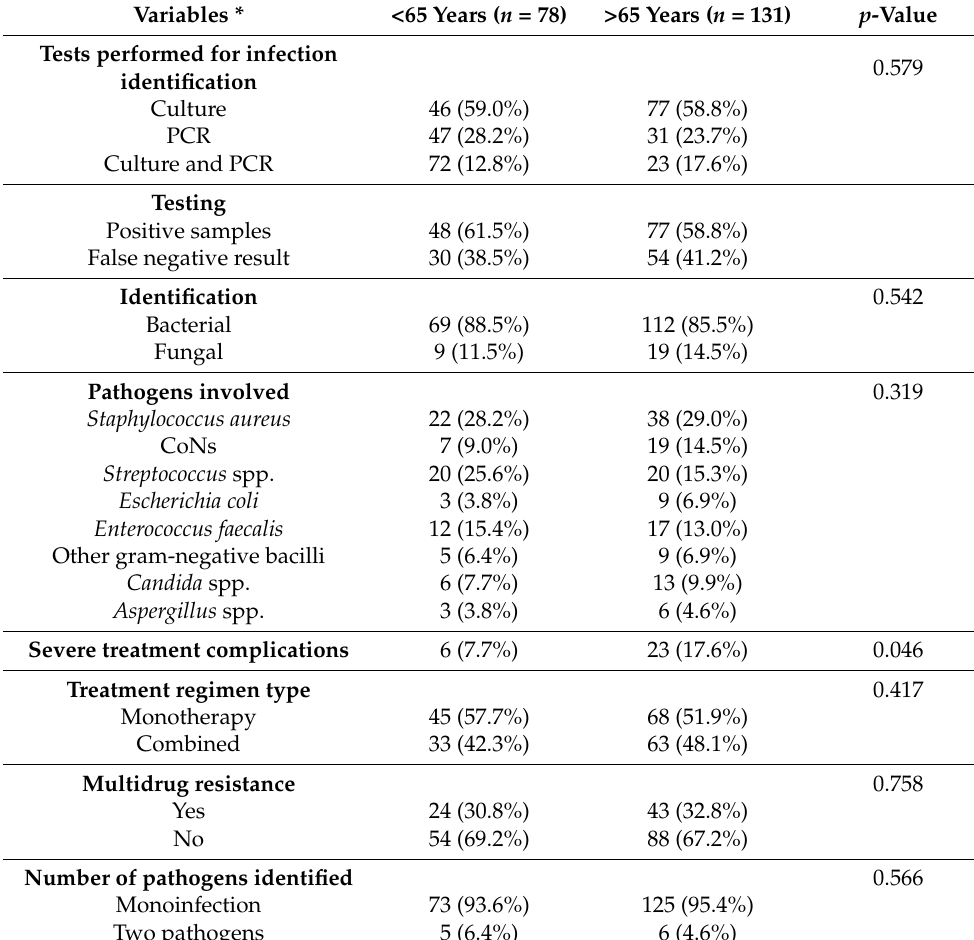
Table 4. Microbial identification and antibacterial and antifungal management.